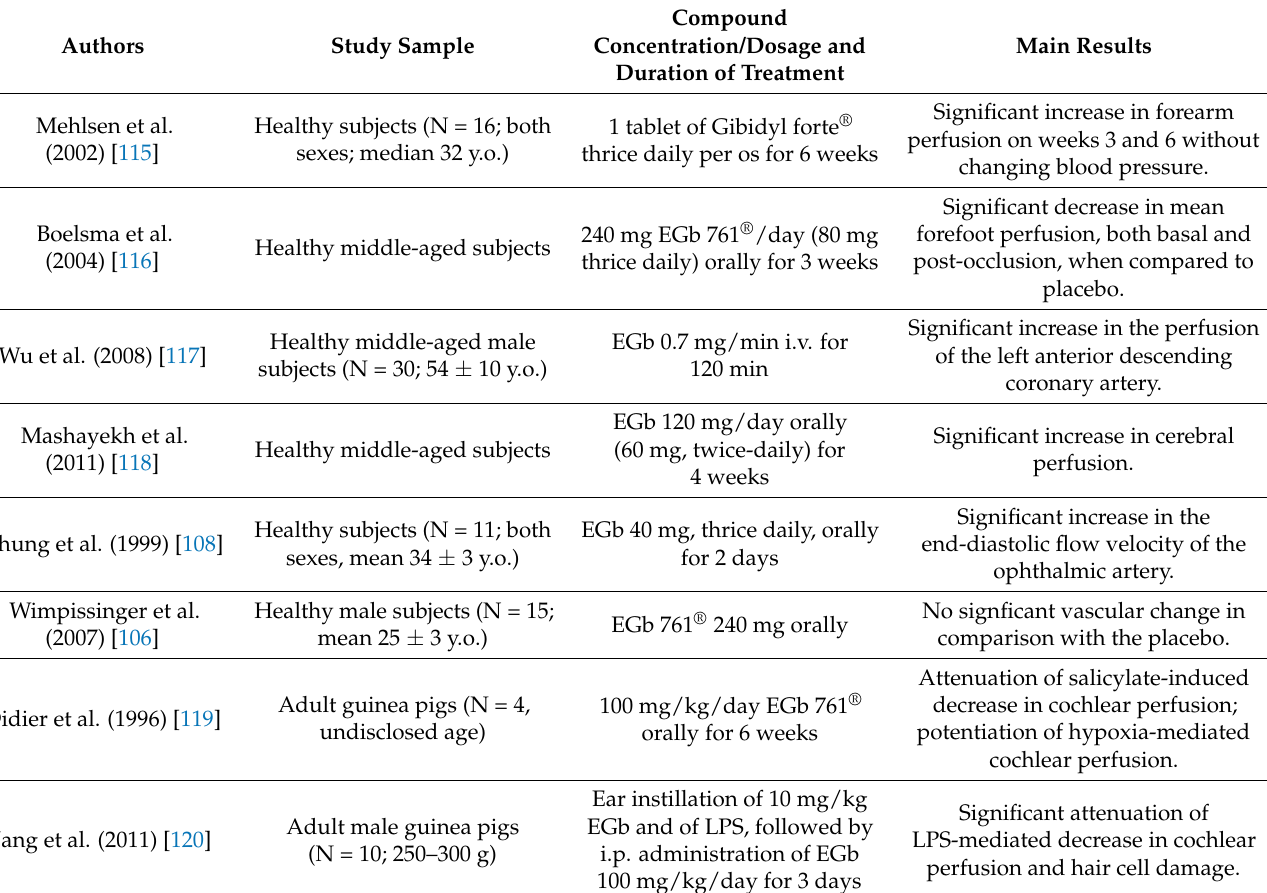
Table 5. Main results of the clinical studies on the effects of Ginkgo biloba extract on organ per- fusion in healthy human subjects and in animals (i.p.—intraperitoneal; i.v.—intravenous; LPS— lipopolysaccharide;y.o.—years